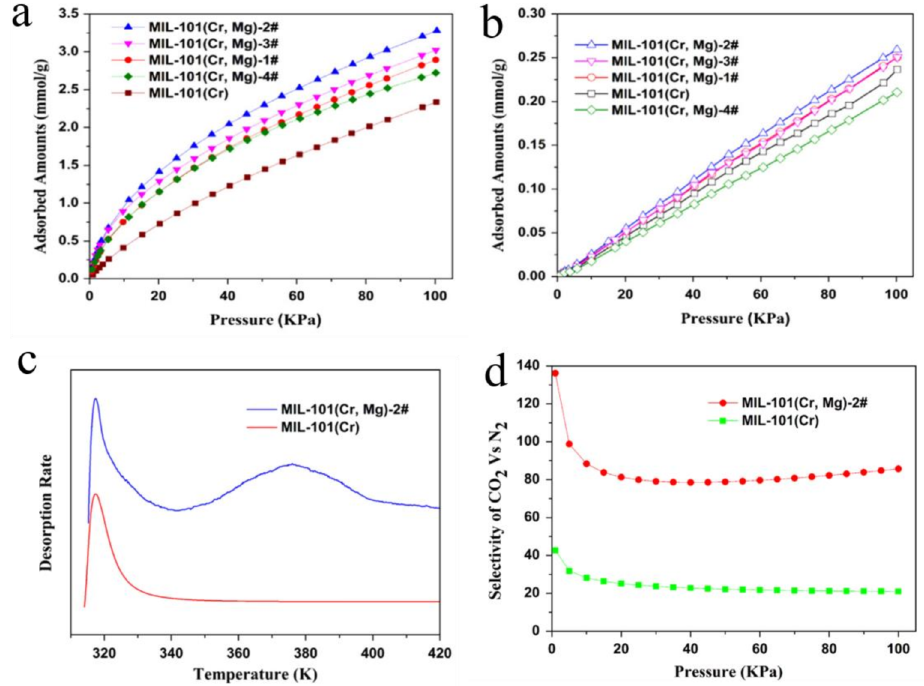
Figure 9. ( a ) CO 2 and ( b ) N 2 adsorption isotherms based on the unit weight of samples at 298 K. ( c ) TPD spectra of CO 2 on MIL-101(Cr) and MIL-101(Cr, Mg)-2#. ( d ) IAST-predicted selectivity for CO 2 /N 2 (0.15/0.85) mixtures on MIL-101(Cr, Mg)-2# at 298 K [93] . Reprinted from ref. [93]. Copyright © 2022, with permission from Elsevier.